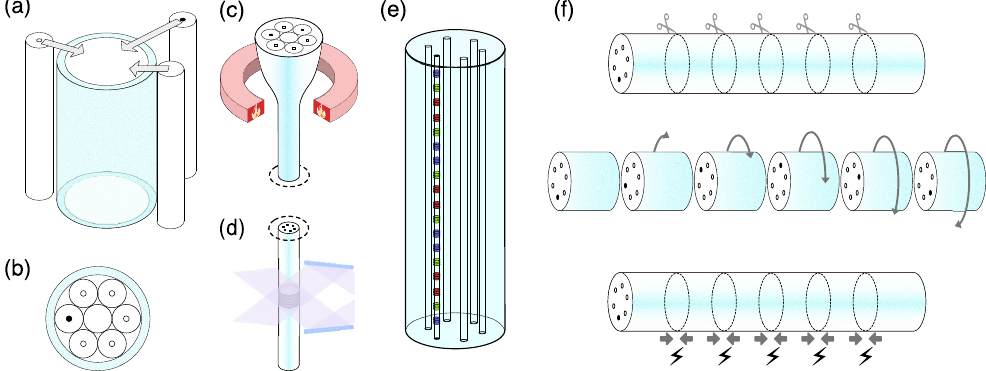
Figure 4. Step-by-step process of a concept fiber component manufacturing. ( a ) Preform stacking. The core material is made from a few sub-preforms with tailored photosensitivities, space between sub-preforms is filled with silica rods. ( b ) Cross-section of a stacked preform. ( c ) Fiber drawing process. ( d ) Fiber Bragg gratings can be inscribed during fiber drawing process. ( e ) The resulting fiber has FBGs inscribed only in photosensitive cores. ( f ) Further fiber handling and component preparation: the fiber is cleaved to obtain a fiber with arrays of FBGs. Then different parts are connected and